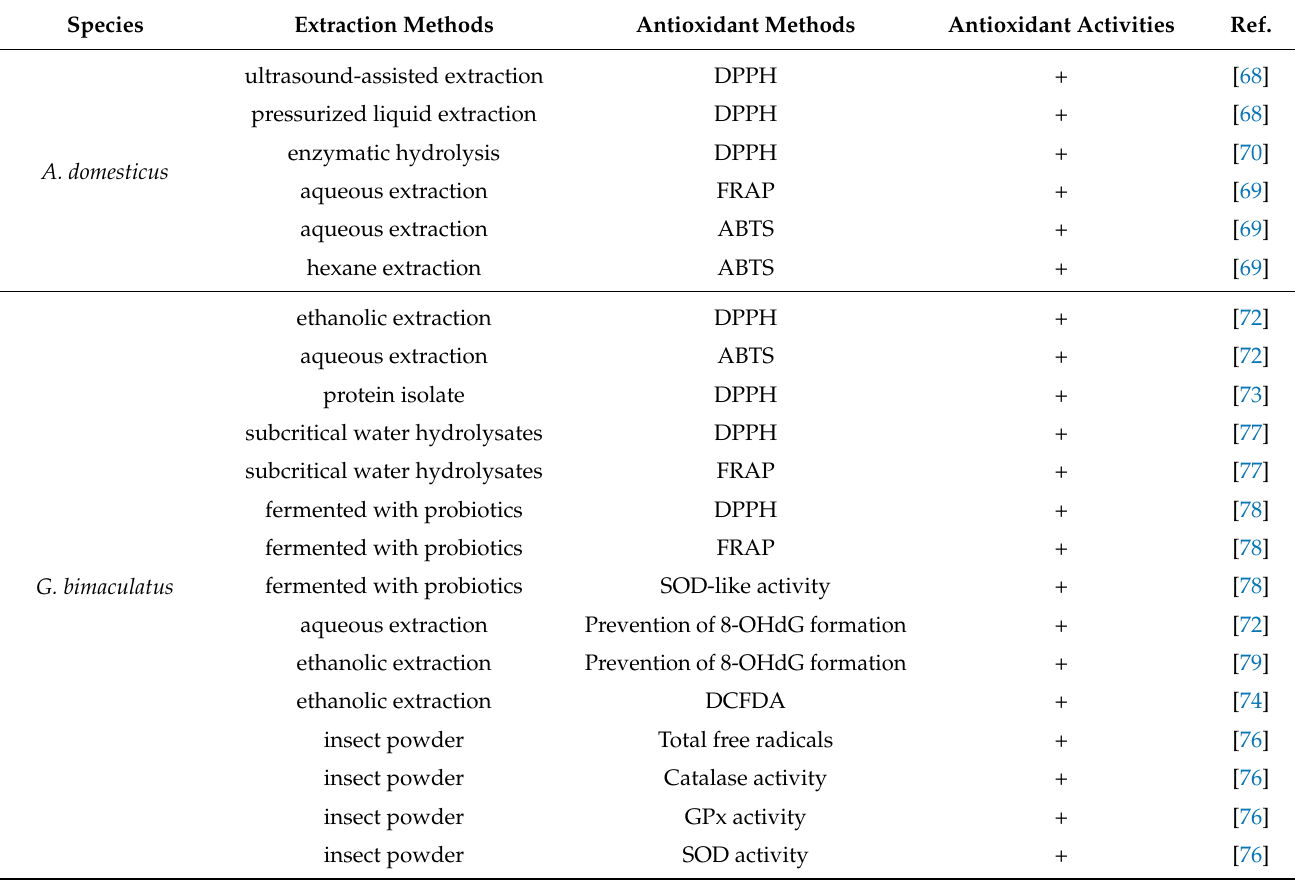
Table 5. Antioxidant activities of A. domesticus and G. bimaculatus determined by various readouts.